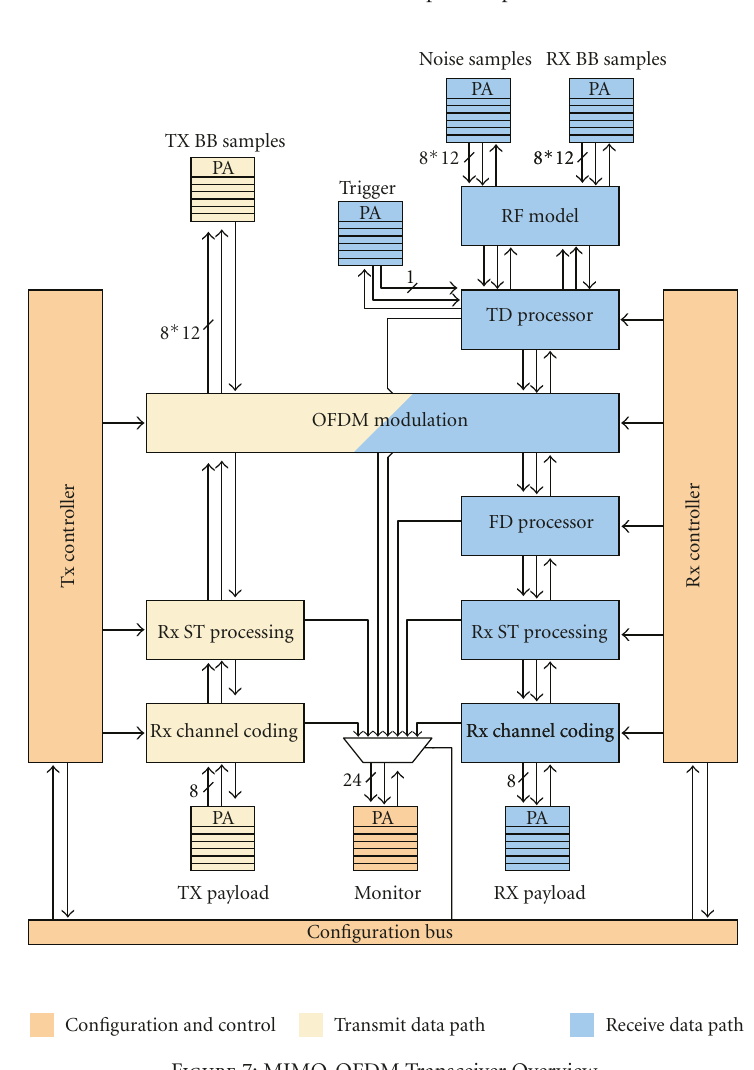
Figure 7: MIMO-OFDM Transceiver